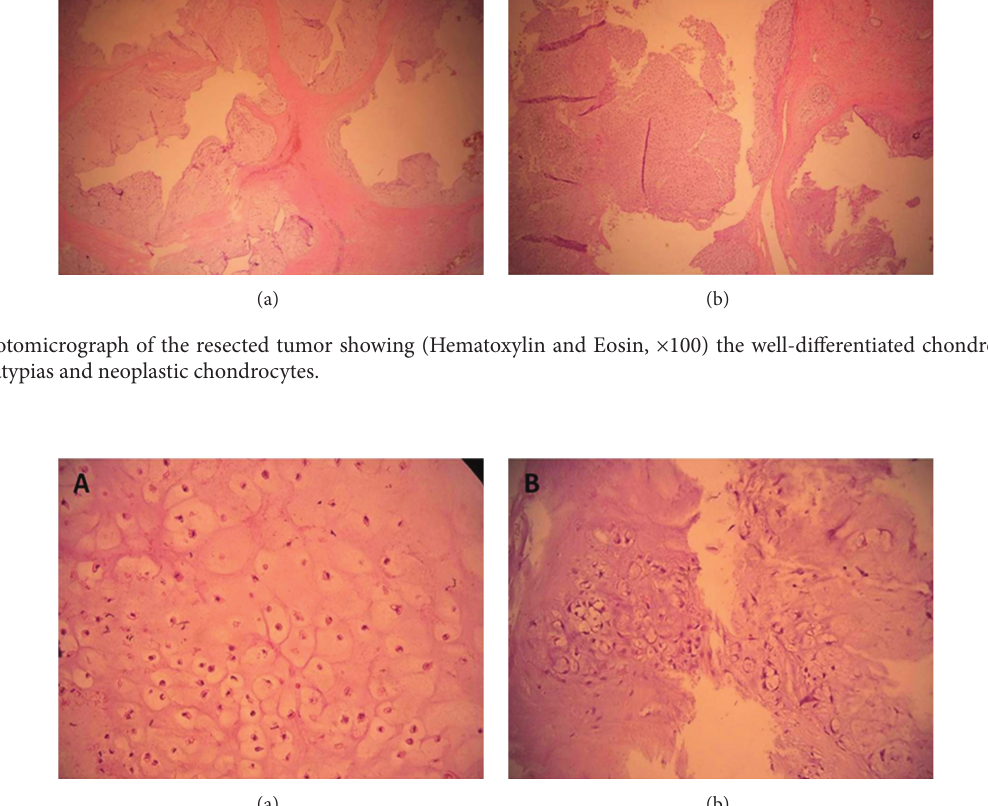
400) increased cellularity, marked atypia, and ×